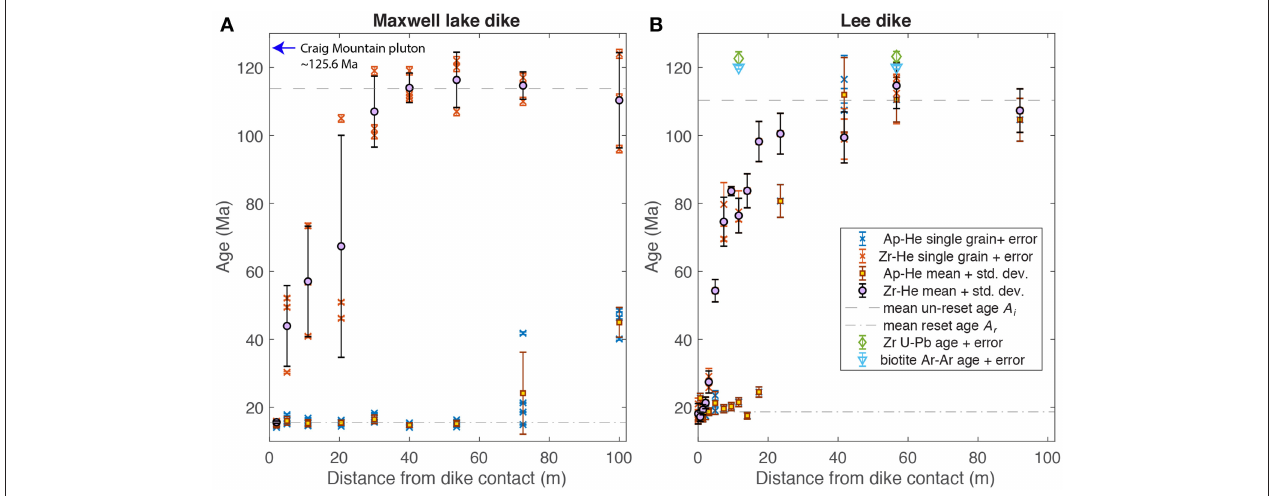
FIGURE 2 | (A,B) Transect of apatite and zircon He thermochronometric ages as a function of distance from Maxwell Lake and Lee dike contacts. Constraints on unrest age of Maxwell Lake comes from Zak et al. (2015), while U-Pb and K-Ar ages constrain host rock ages at Lee dike. Dashed lines are mean of thermochronometric ages used for A r and A i in Equation